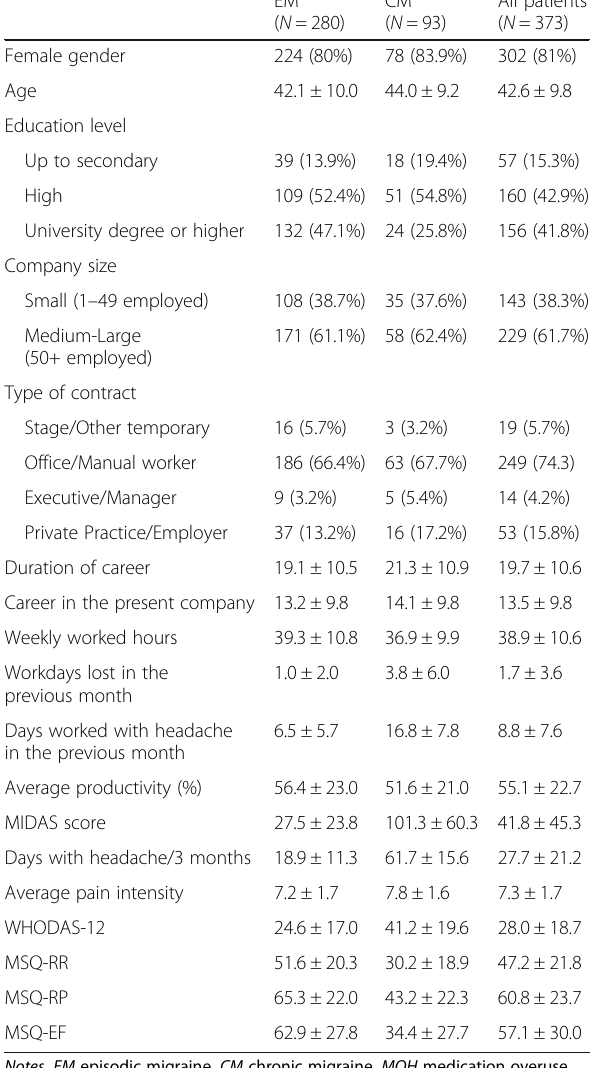
Table 1 Sociodemographic characteristics of the HEADWORK validation